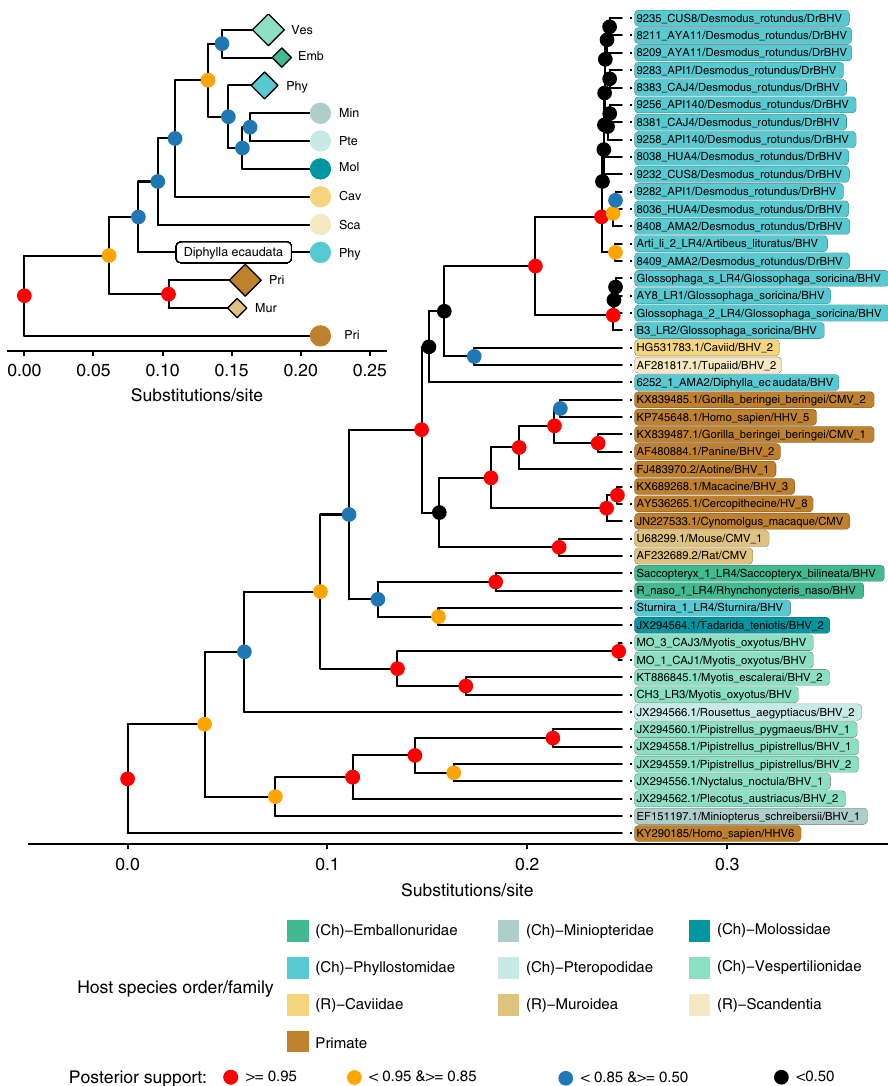
Fig. 3 Bayesian phylogenetic tree of mammalian BHV shows clustering of virus diversity by host taxonomy. Nucleotide-based phylogeny of UL89 sequences (304 bp) showing clusters of BHVs that were generally restricted to single species. Posterior probabilities are represented by node colour. Tip labels are coloured according to host taxonomy (family level for orders Chiroptera and Rodentia, and order level for Primates) and include the host species in which the BHV was detected and GenBank accession number where appropriate. The inset amino acid sequence-based phylogeny recovers the monophyly of bat BHVs and indicates bat family speci fi c clustering of viral diversity, apart from a BHV from Di. ecaudata which groups separately from all other BHVs from Phyllostomid bats. Clades are collapsed into bat families, primate and rodent groups, represented by the diamond tips, proportional to the size of the collapsed clade. Individuals are represented by circular tips. Colours and family/order abbreviations correspond to those in the main fi gure. Both datasets include human herpesvirus 6A (HHV6, genus Roseolovirus) as an